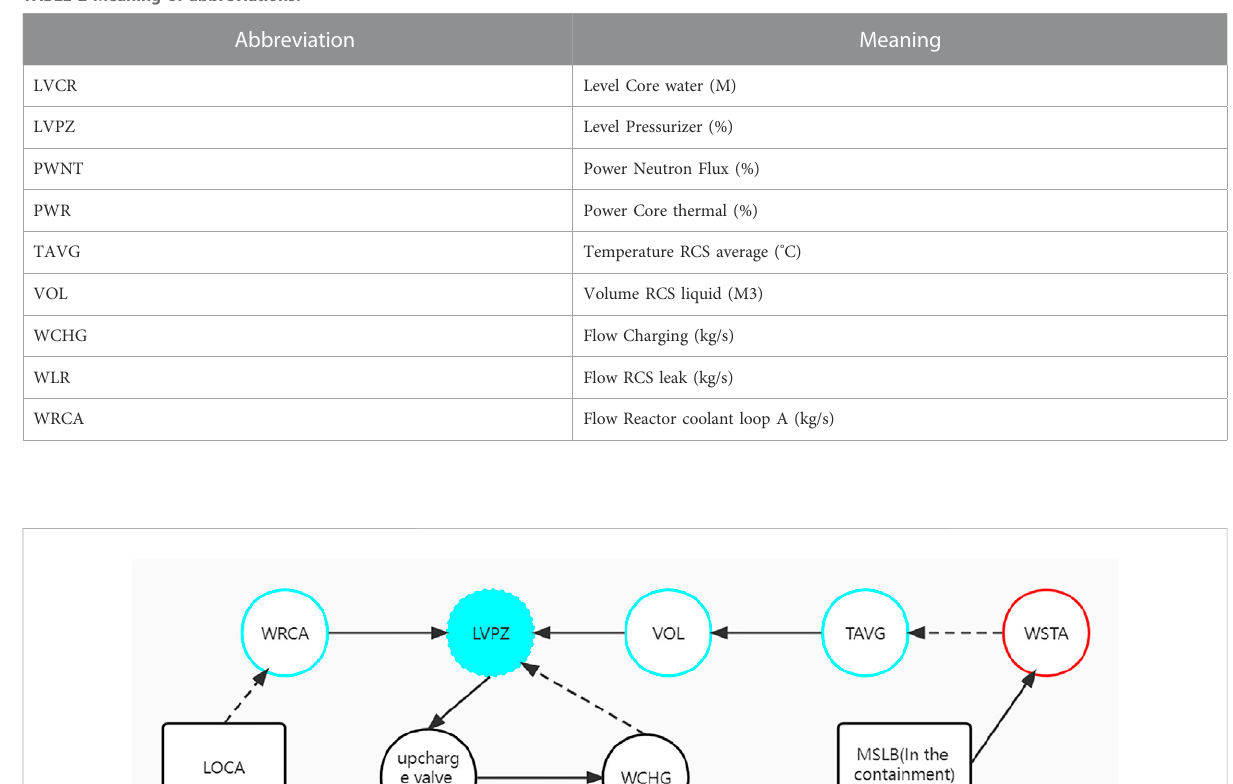
TABLE 2 Meaning of abbreviations.